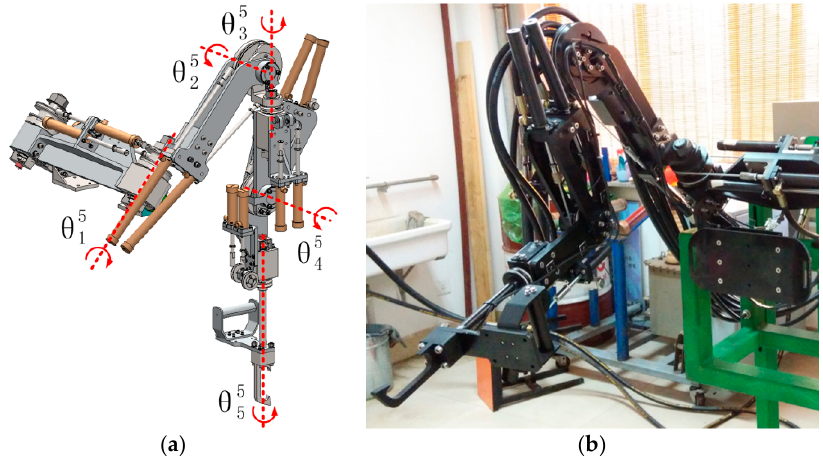
Figure 2. ( a ) The model of the 5 ‐ DOF upper ‐ limb exoskeleton; and ( b ) The 5 ‐ DOF upper ‐ limb exoskeleton. Table 1. Motion range of human joints.